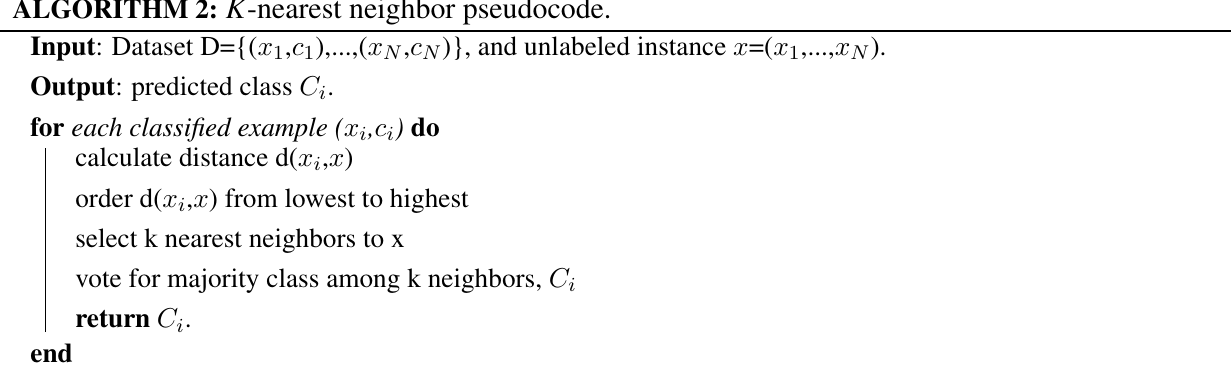
ALGORITHM 2: K -nearest neighbor